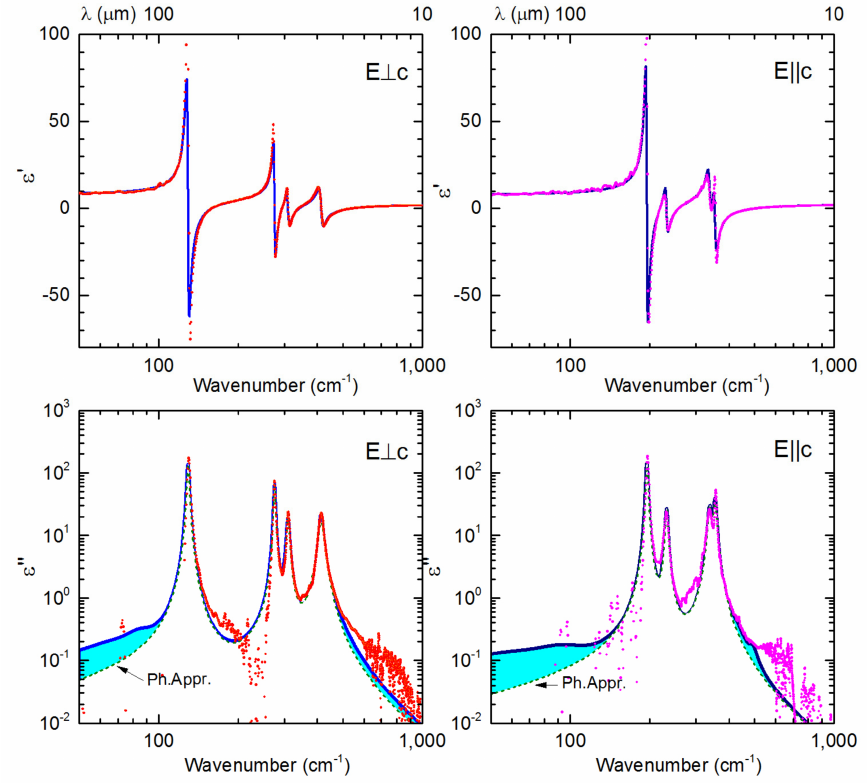
Figure 5. Spectra of complex dielectric permittivity of LiGdF 4 single crystal along principal crystallo- graphic direction with E ⊥ c and E (cid:107) c. Solid lines show spectra simulated using parameters listed in Tables 1 and 2. Dashed lines show the extrapolation of the simulated spectra using only A u and E u phonons contribution. Dots show spectra obtained using Kramers–Krönig